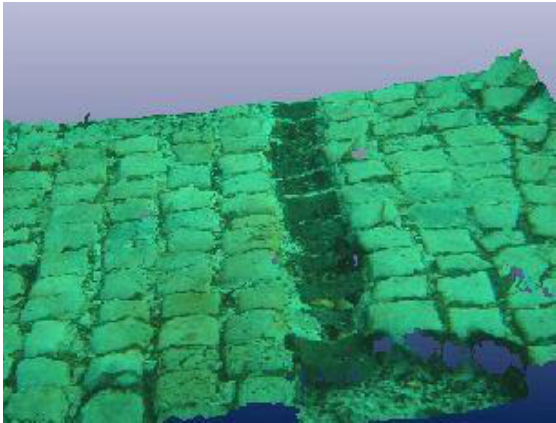
Figure 5. Underwater laser Scanner digital model of a part of a mosaic